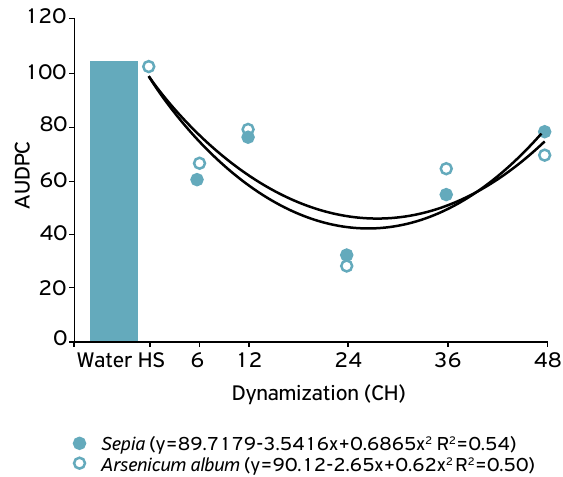
Figure 3. Area under the disease progress curve (AUDPC) of Macrophomina phaseolina from the second experiment carried out in potted soybean plants grown in a greenhouse and treated with dynamizations of the homeopathic drugs Sepia and Arsenicum album